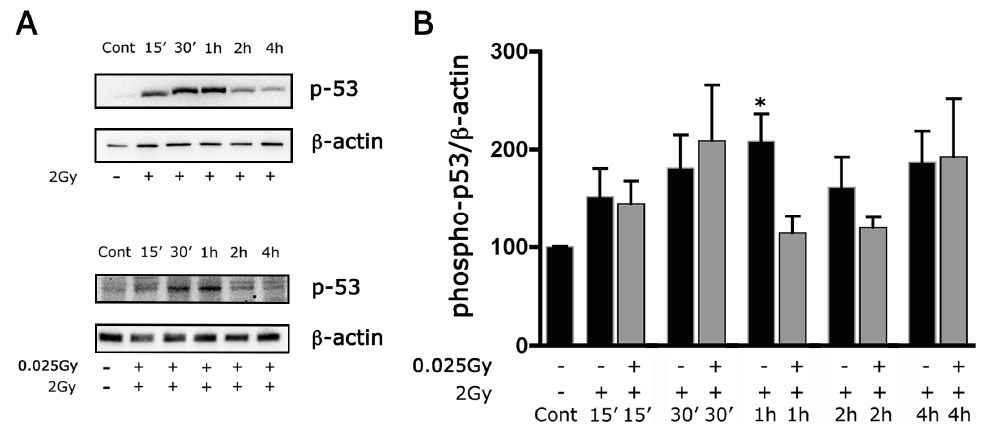
Figure 4. The priming dose reduces the expression of phospho-p53 induced by irradiation with 2 Gy. Western blots at different times in cultures after irradiation with a challenging dose (2 Gy) and in cultures pre-irradiated with a priming dose (0.025 Gy). Whole-cell lysates were prepared from retinal cultures. ( A ) Equal amounts of total protein from each lysate were resolved on 10% SDS-PAGE and transferred to nitrocellulose membranes. Membranes were probed with anti-rabbit polyclonal anti-phospho-p53 Ser15. β -actin levels were used as a control of protein loading. Blots are representative of five independent experiments. ( B ) Bar graphs represent the mean ± SEM from five independent experiments as in A. * p < 0.05 versus control, Wilcoxon signed ‐ rank test.